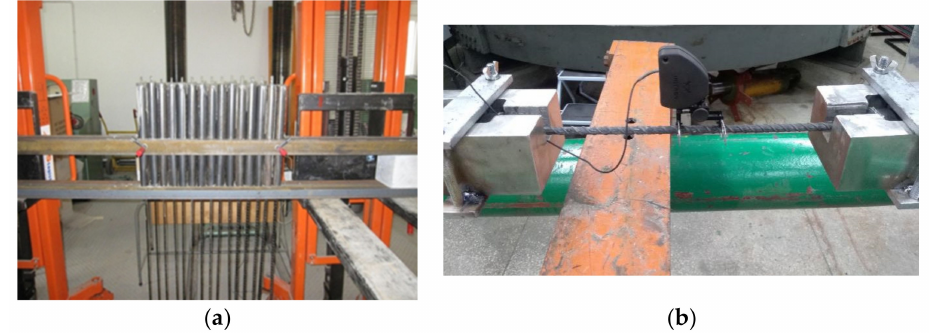
Figure 2. ( a ) Basalt Fiber Reinforced Polymers (BFRP) bars prepared for testing, ( b ) Hybrid Fiber Reinforced Polymers (HFRP) bars in the tensile testing